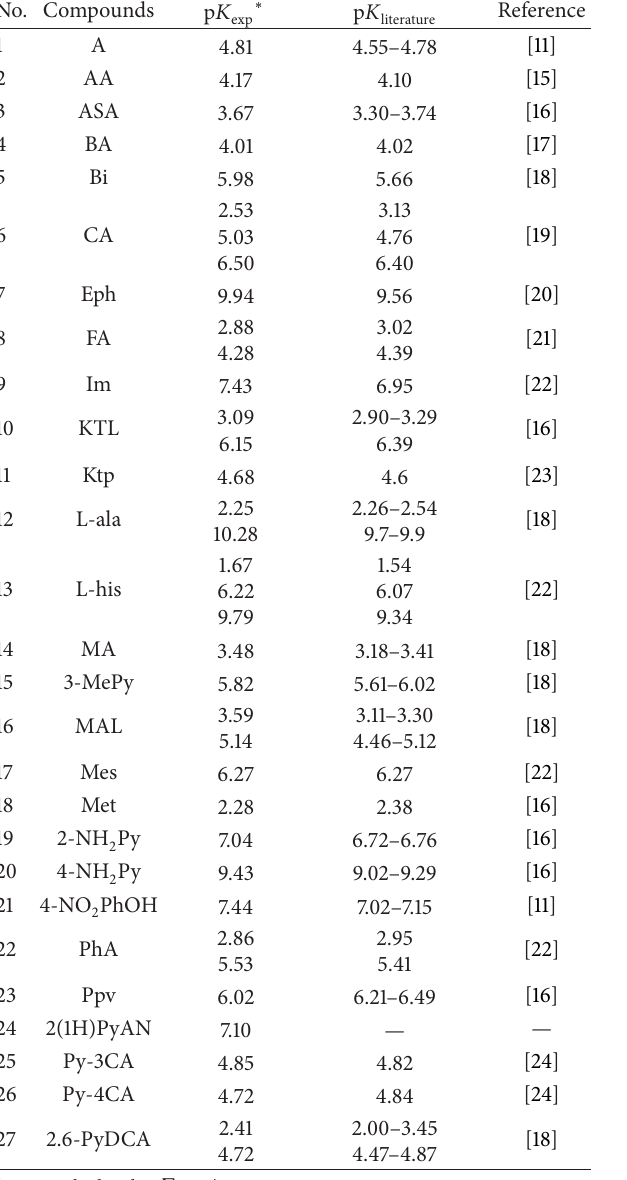
Table11:Experimentalandliteraturep 𝐾 under